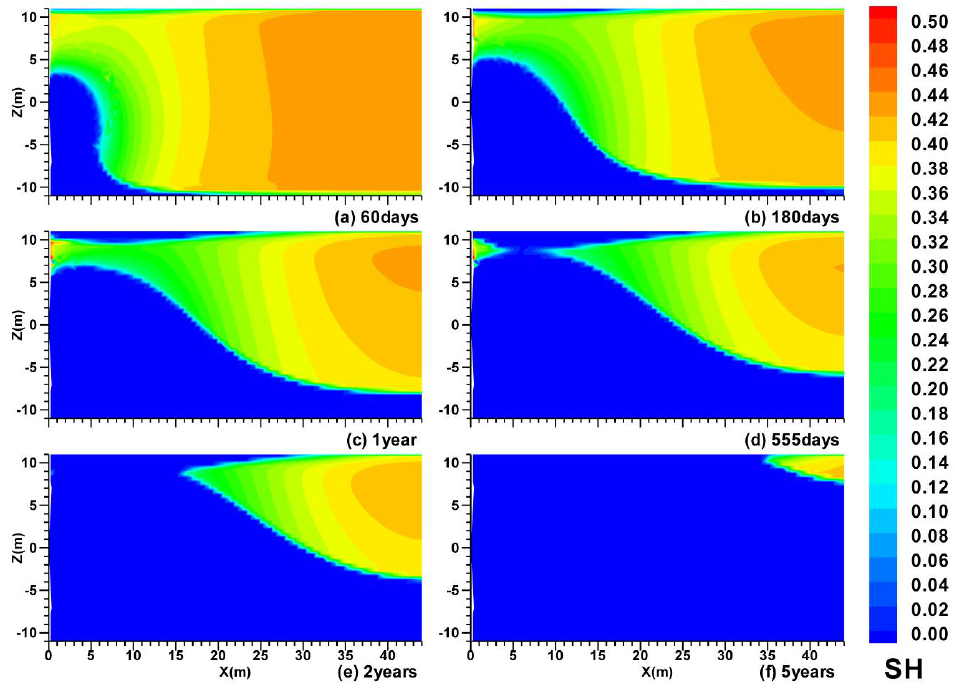
with impermeable OB and permeable UB H